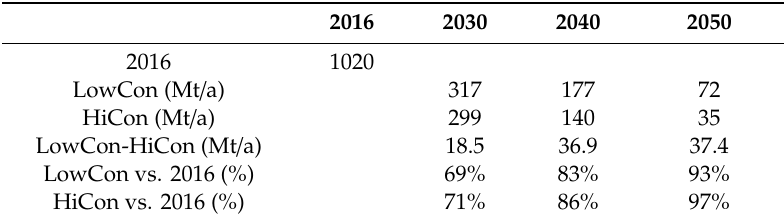
Table 2. CO 2 emissions in the ENTSO-E area in 2016 and in the scenario years (absolute (Mt / a), e ff ect of lower connectivity (Mt / a), and reduction compared to 2016 (%)). Source: 2016